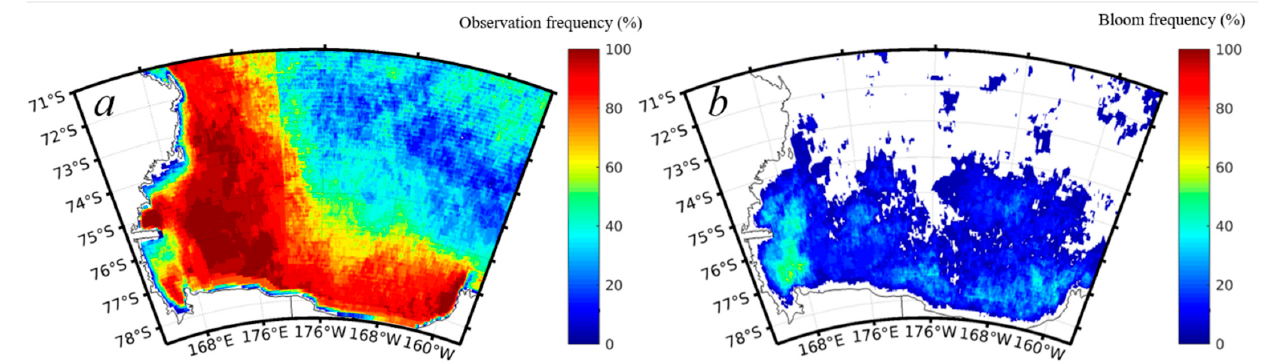
Figure 3. ( a ) Observation frequency of valid satellite observations in the Ross Sea between 2002 and 2020 from MODIS. ( b ) Same as Figure 2, but bloom frequency derived using the NASA standard Chl algorithm.